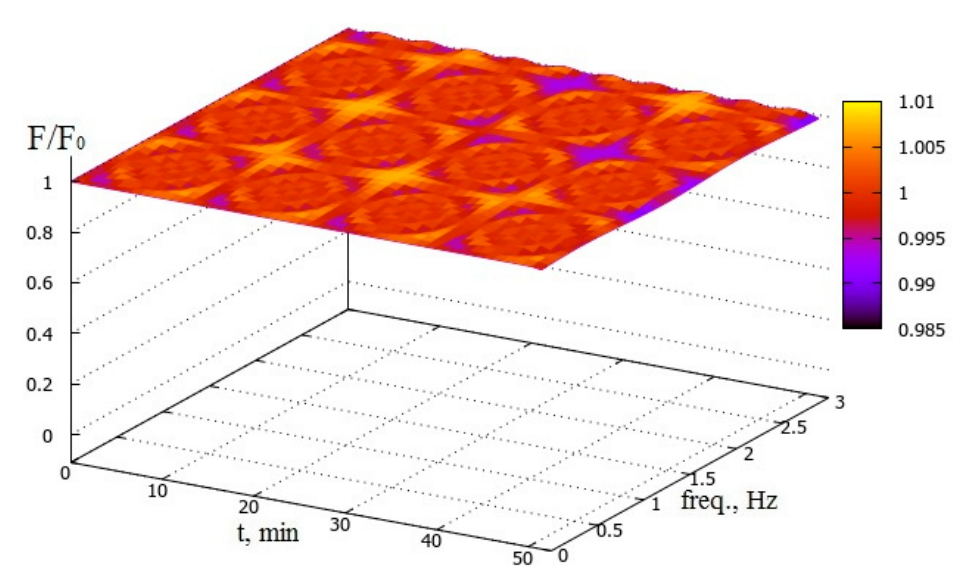
Figure 6. The reaction force surface.